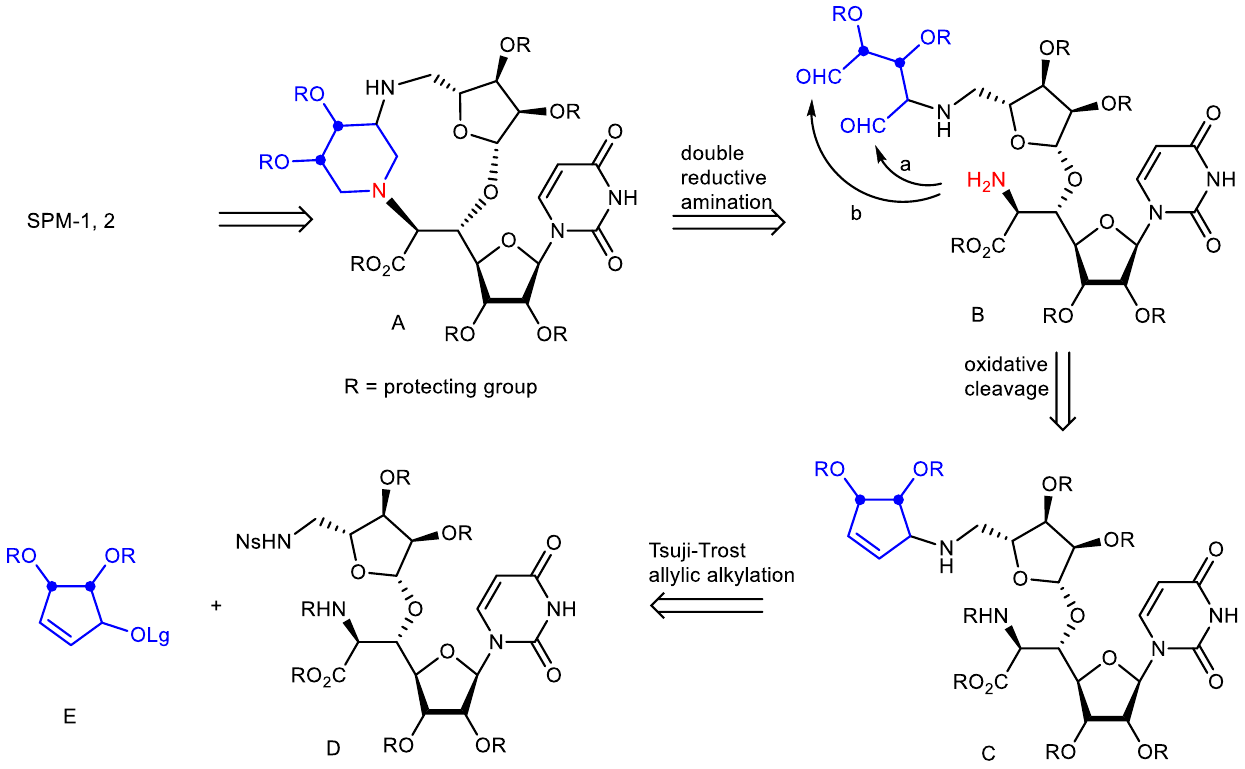
Fig. 3 | Retrosynthetic analysis of SPM-1 and SPM-2. The macrocycle and the piperidineringofAareconstructedsimultaneouslybydouble-reductiveamination of aminodialdehydeB.ThedialdehydeBarisesfromacyclopenteneCbyoxidative